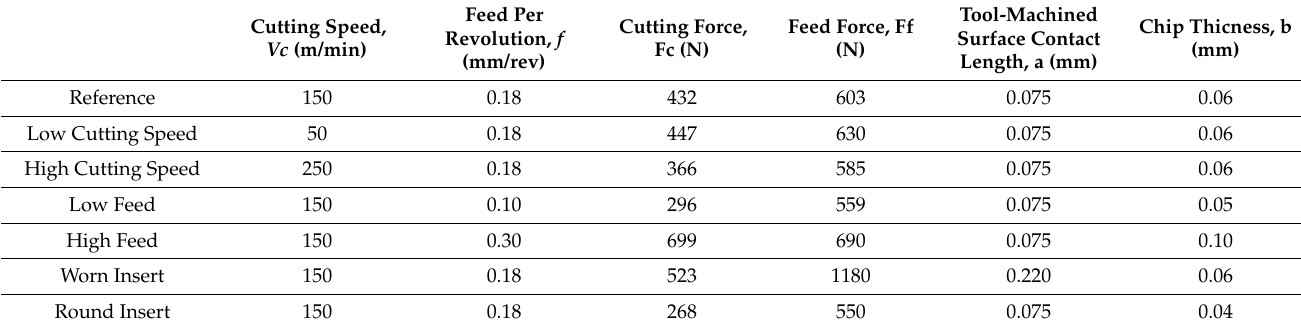
Table 5. Physical parameters measured during experimental cutting tests.